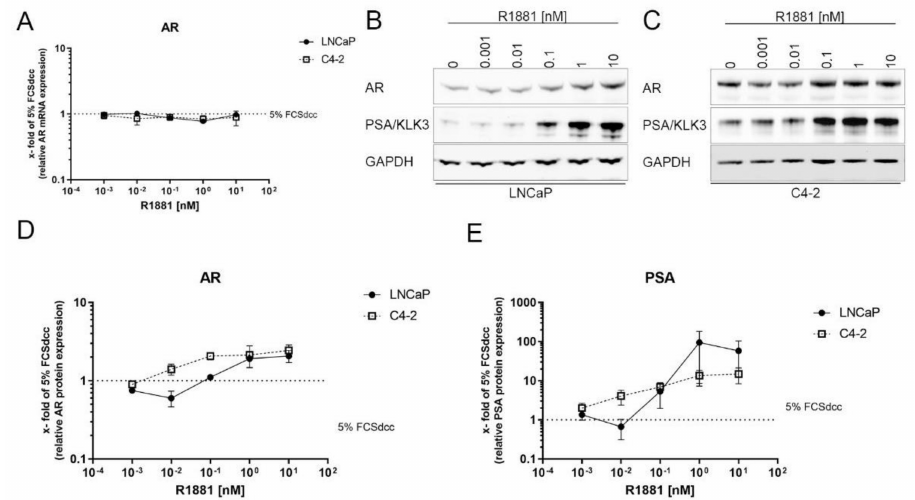
Figure 4. R1881 changes AR protein in a transcription-independent way: ( A ) Relative change of AR mRNA levels after 16 h treatment with increasing concentrations of R1881 in LNCaP and C4-2 cells. Values are expressed as x-fold of untreated cells and are displayed as mean ± s.e.m. ( n = 3). ( B , C ) Representative Western Blot of 72 h R1881 treated LNCaP ( B ) and C4-2 ( C ) cells. ( D ) Relative change of AR protein in LNCaP and C4-2 cells after 72 h treatment with increasing concentrations of R1881. Values are expressed as x-fold of untreated cells and are displayed as mean ± s.d. ( n = 3). ( E ) Relative change of the treatment response PSA in LNCaP and C4-2 cells after 72 h treatment with increasing concentrations of R1881. Values are expressed as x-fold of untreated cells and are displayed as mean ± s.d. ( n = 3). Uncropped Western blots are displayed in Figure